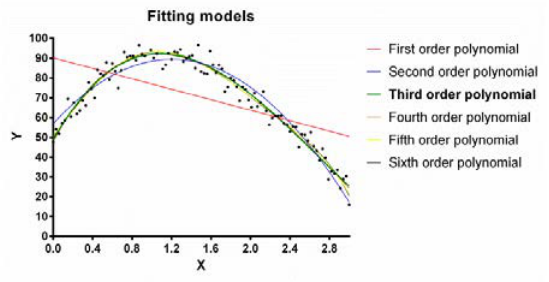
Table 2. Result with middle sample (31 points).